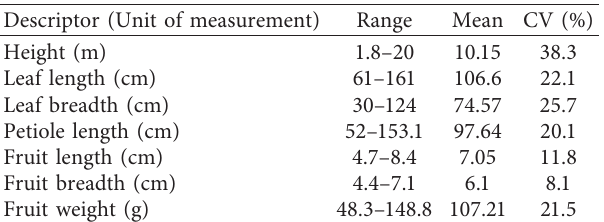
Table 3: Frequency distribution table of the quantitative mor- phological traits used for the morphological characterization of doum palm.